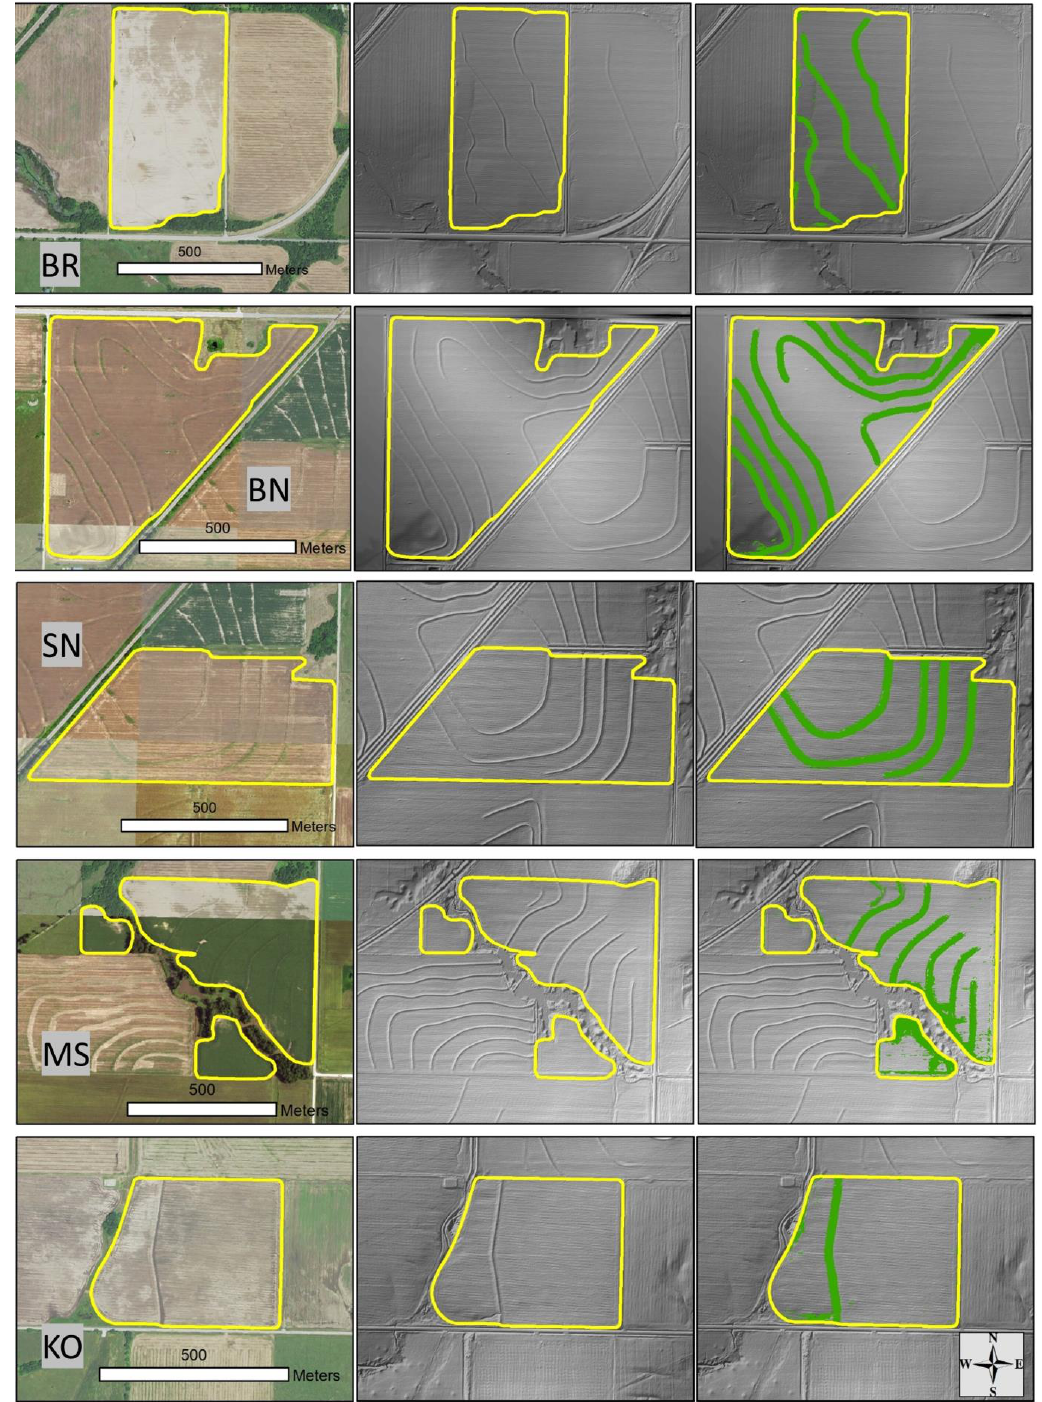
Figure 2. The five research sites used for this study in Ottawa County, Oklahoma. The images in the first column are visible reflectance data taken from the National Agricultural Imagery Program dataset [32], showing some indication of terracing patterns. Site boundaries are outlined in yellow and site identification codes are given in black letters on a gray background. The center column shows a hillshade model derived from the digital elevation model [11] for each site, with terrace features faintly visible as shaded linear regions. Higher relative elevations are given a lighter shade of gray, and lower elevations are darker. The third column shows the results of the top performing classification algorithm as green linear features covering the predicted regions of terraces, their “borrow” zones from the uphill side, and their “deposition” zones on the downhill